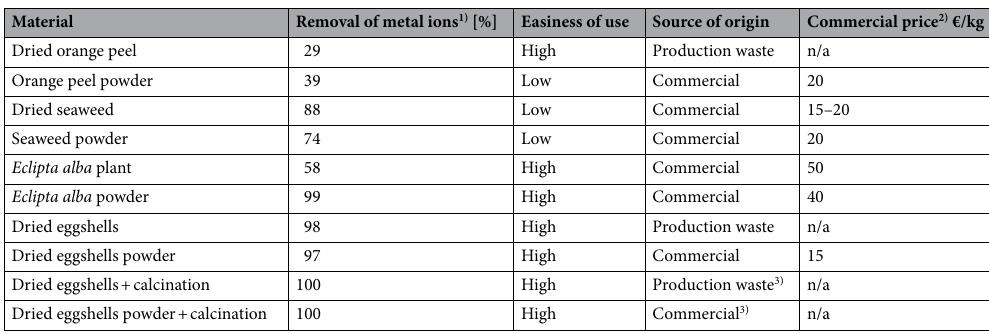
Table 1. Characteristics of materials selected for testing. 1 Fe(III), Cr(III), Ni(II), Cu(II) from acidic electropolishing industrial wastewater. 2 Average price in Polish market. 3 Source of initial material before calcination process. n/a–Not